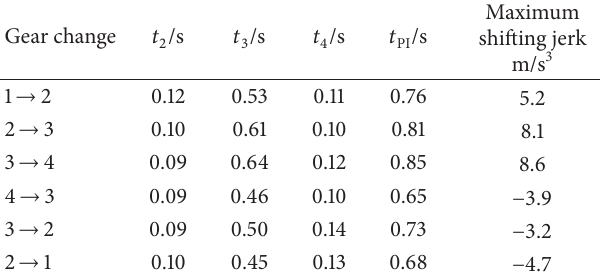
Table 3: The statistical data of the gearshift